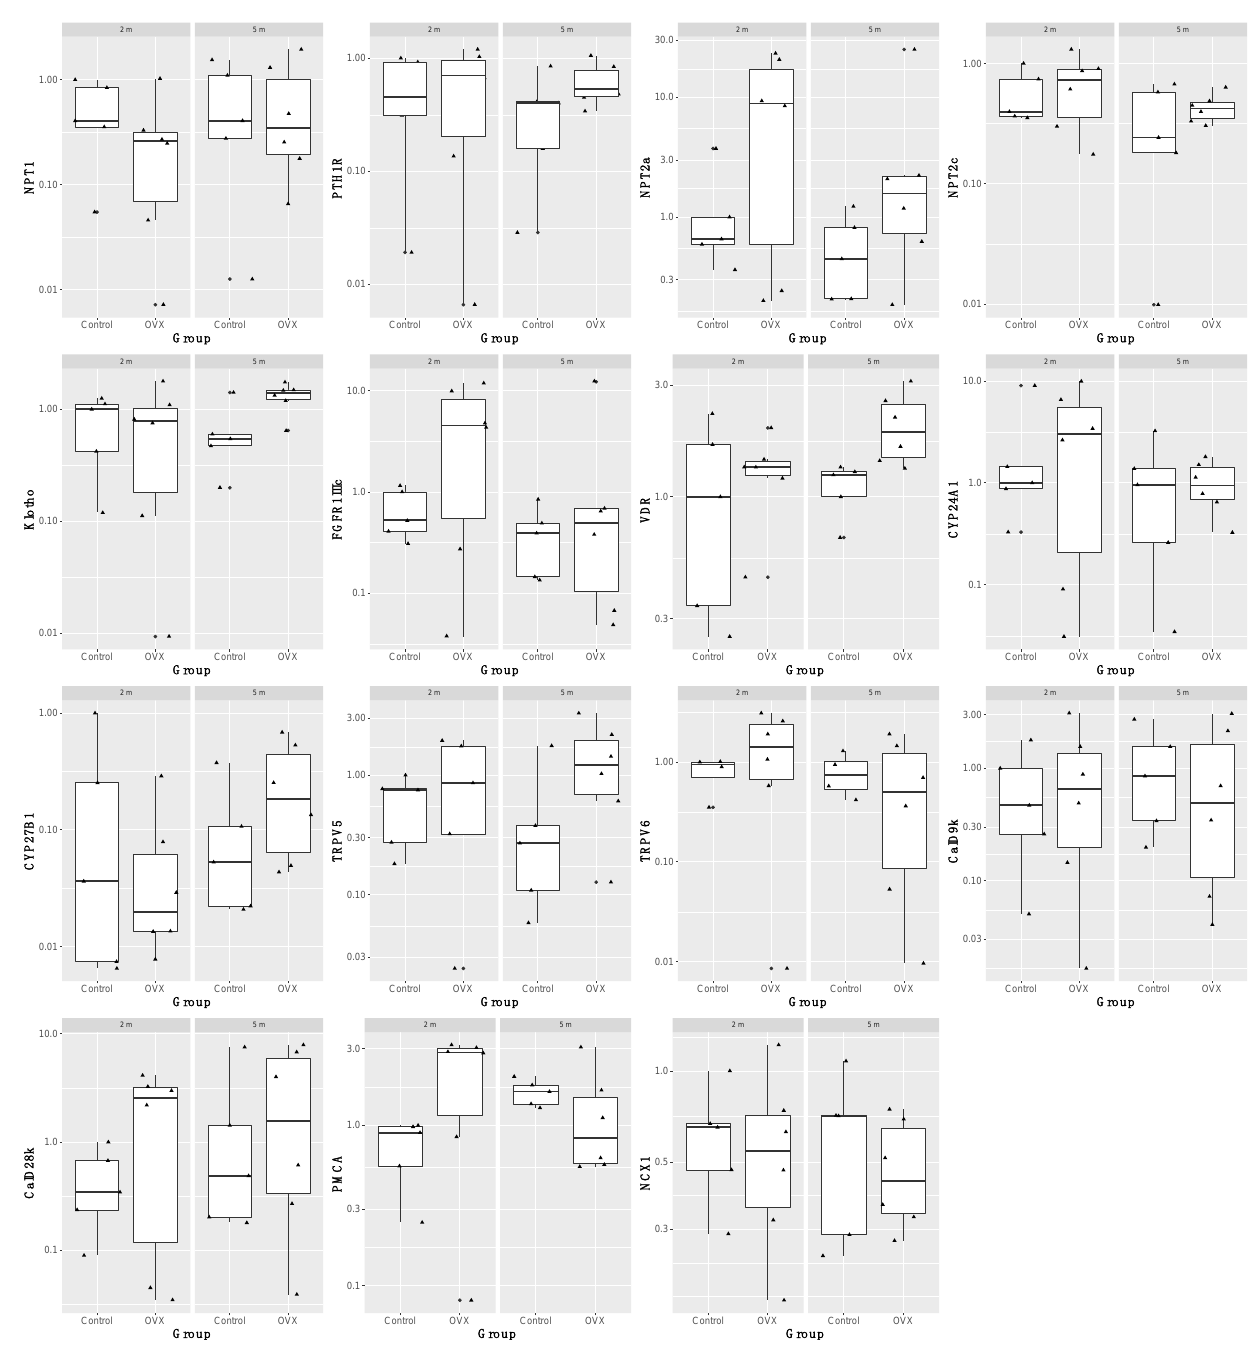
Figure 2. Boxplot of log 10 transformed renal gene fold expression in control and ovariectomized (OVX) sheep euthanized at 2 and 5 months. Genes examined include: sodium-phosphate co-transporters (NPT1 , NPT2a , NPT2c) , parathyroid hormone 1 receptor (PTH1R) , α -klotho, fibroblast growth factor receptor 1 IIIc (FGFR1IIIc) , vitamin D receptor (VDR) , cytochrome P450 family 24 subfamily A polypeptide 1 (CYP24A1) , cytochrome P450 family 27 subfamily B polypeptide 1 (CYP27B1) , transient receptor potential cation channel subfamily V member 5 and 6 ( TRPV5 , TRPV6 ), calbindin D9k (CalD9k), calbindin D28k ( CalD28k ), plasma membrane calcium ATPase ( PMCA ), sodium calcium exchanger 1 (NCX1). Black circle next to triangle indicates that point is an outlier.